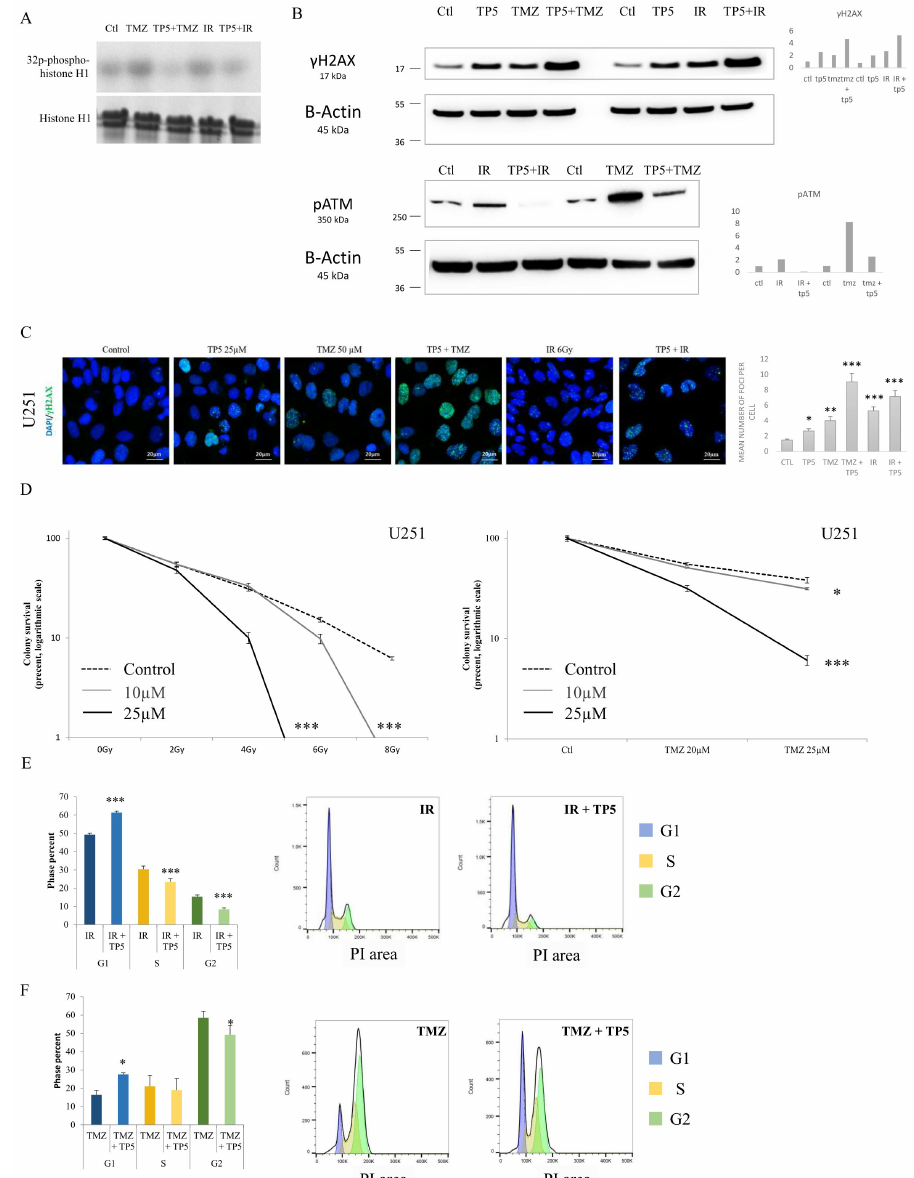
Figure 4. TP5 acts synergistically with chemotherapy and radiotherapy. ( A ) CDK5 activity is shown by phosphorylated histone 1 in U251 cells treated as indicated (Ctl: control; TMZ: temozolomide 50 µ M; TP5: 25 µ M; IR: irradiation 6 Gy). ( B ) The protein levels of γ H2A.X and phosphorylated ATM are shown by Western blot in U251 cells treated as indicated (Ctl: control; TMZ: temozolomide 50 µ M; TP5: 25 µ M; IR: irradiation 6 Gy). ( C ) Left panel: Immunofluorescent staining of γ H2A.X (green) in U251 cells after treatment as indicated. Right panel: the bar graph displays the quantification of γ H2A.X foci per cell treated as indicated (ten random fields of view for each group, on 3 distinct experiments; * p < 0.05; ** p < 0.01; *** p < 0.001). ( D ) Synergistic interactions between TP5 and irradiation (left graph) or chemotherapy (TMZ: temozolomide, right panel) are shown by clonogenic growth of U251 cells treated as indicated (TP5 at 10 and 25 µ M; irradiation from 0 to 8 Gy; TMZ at 20 and 25 µ M) ( N = 3; * p < 0.05; *** p < 0.001). ( E ) Cell cycle analysis is shown for U251 cells treated by TP5 (25 µ M) and irradiation (6 Gy) for 48 h. The graph bar displays the cell cycle phase quantification ( N = 4; *** p < 0.001). ( F ) Cell cycle analysis is shown for U251 cells treated by TP5 (25 µ M) and TMZ (50 µ M) for 48 h. The graph bar displays the cell cycle phase quantification ( N = 3; * p <